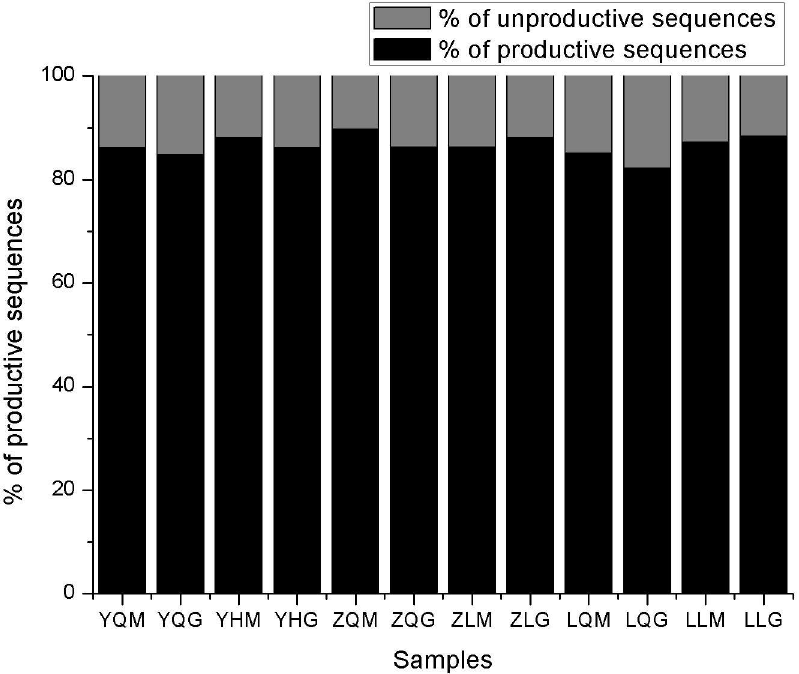
Fig 1. The percentage of productive sequences in the repertoiresof IgM and IgG before and after immunization with HBV vaccinesin 3